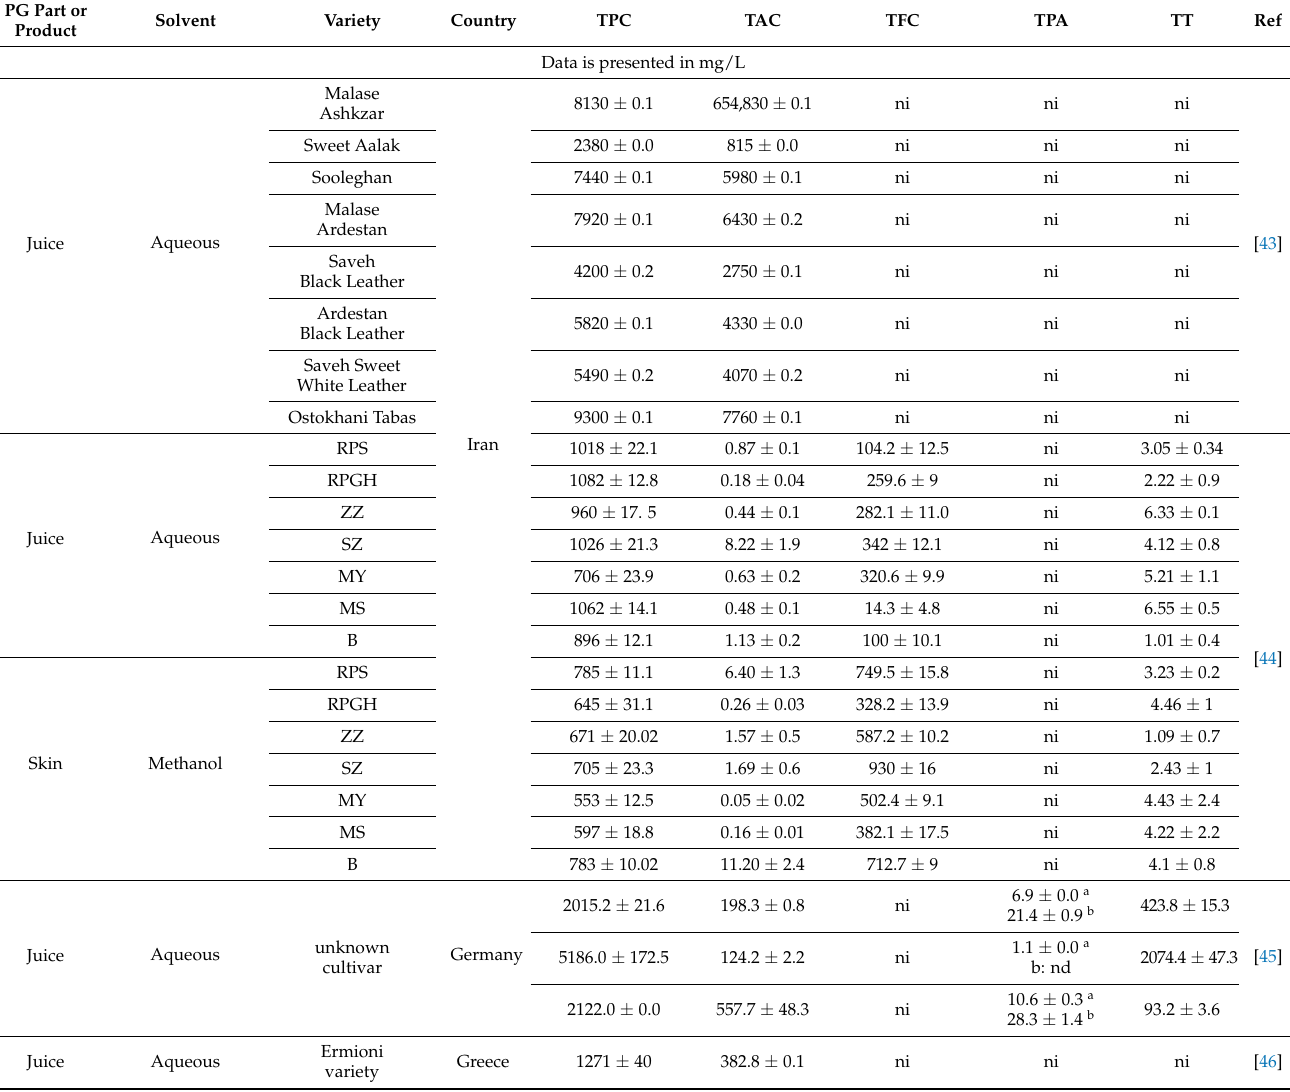
Table 2. Summary of quantification findings in terms of total phenolic, total flavonoid, total antho- cyanin, and total tannin content in different pomegranate parts and